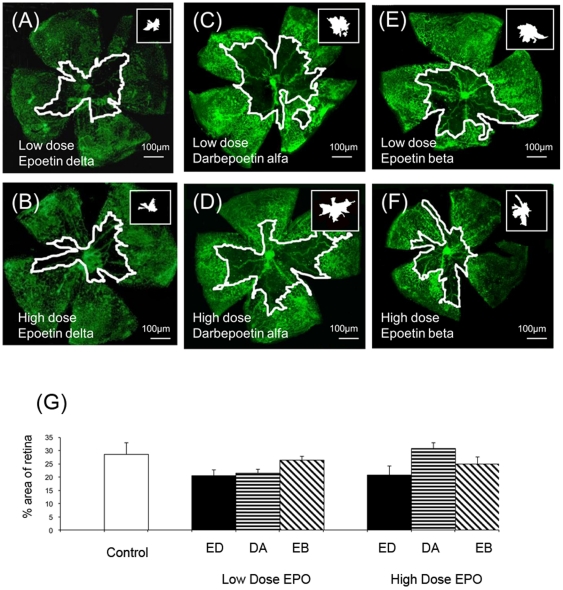
Representative flat-mounts of the retinas following OIR treated with the three ESAs.Flat-mounted retina shows the ischaemic areas highlighted following treatment with low dose of epoetin delta (ED) (A) darbepoetin alfa (DA) (B) epoetin beta (EB) (C) and high dose of epoetin delta (D) darbepoetin alfa (E) and epoetin beta (F). Epoetin Delta, Darbepoetin Alfa or Epoetin Beta treatment of pups with OIR from P12–P17 at low or high dose had no significant influence on the extent of retinal ischaemia (avascular area) (G).